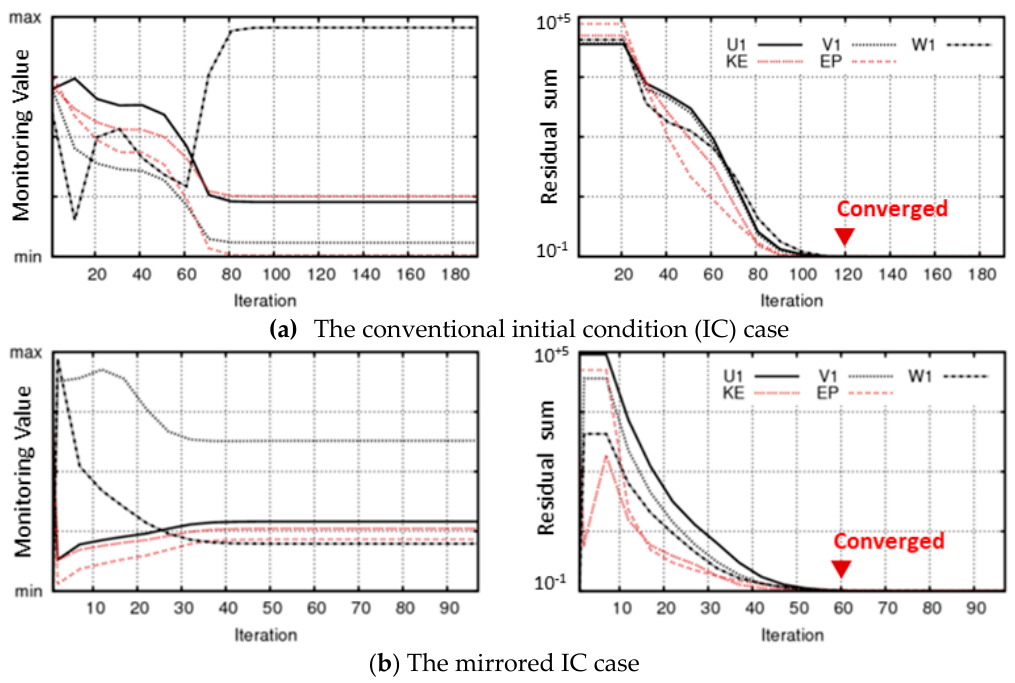
Figure 6. Comparison of the convergence history of monitoring values of the field variables (normalized